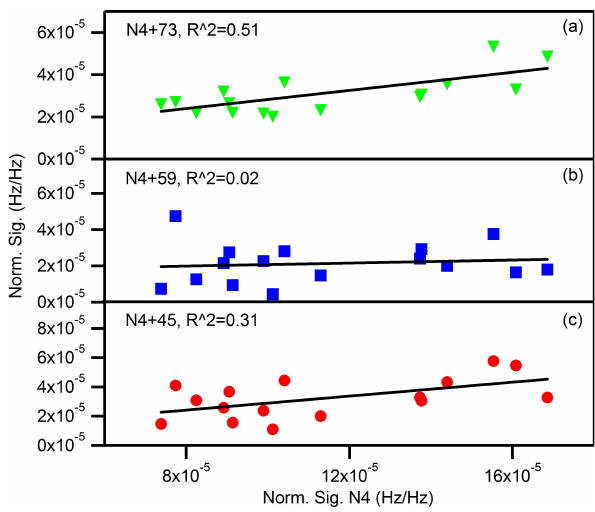
Fig. 8. Correlation of individual amine cluster concentration with sulfuric acid tetramer (N4) (normalized) for selecting peaks only during the event period (10:00–14:00) from Fig. 7.